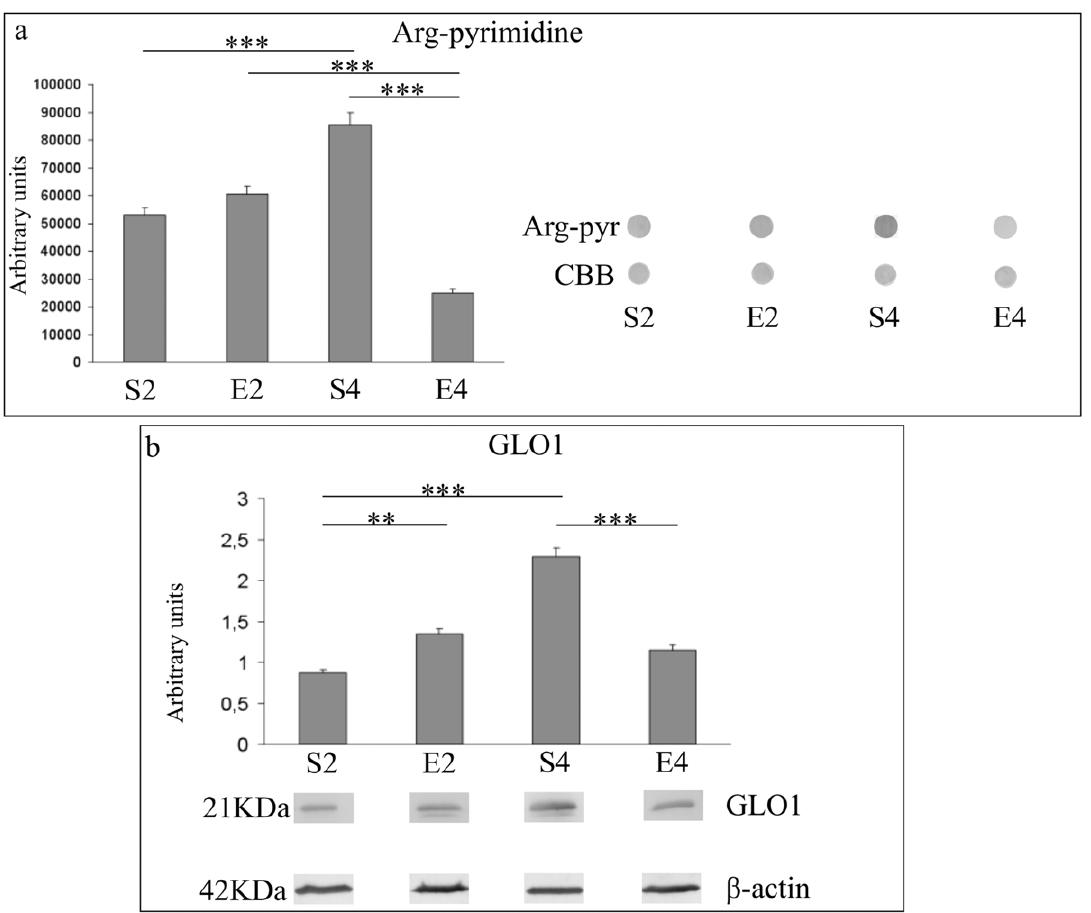
Figure 6. MG-related protein damage and expression of MG-targeting detoxification system in hippocampi of mice undergoing 2- or 4-mo moderate treadmill running. Immunoreactivity levels against arg-pyrimidine and protein expression of glyoxalase 1 (GLO1) in hippocampi of mature CD-1 female mice undergoing a two- or four-month moderate and regular treadmill-based exercise program (E2 or E4, respectively); age-matched sedentary animals (S2, S4) were used as controls (n=12 per group). As shown in panel a, an age-dependent increase in the levels of MG-damaged protein was detected (S4 vs S2), and an increasing trend in MG-related protein damage was observed after 2 months of running (E2 vs S2). The immunoreactivity against arg-pyrimidine decreased after 4 months of regular exercise (E4 vs S4). Dot-blots signals were normalized against the Comassie Brilliant Blue-based total protein staining. In the panel a, right section, representative dot immunoblots of three independent experiments were reported. As reported in panel b, an age-dependent increase in the GLO1 protein expression levels was detected (S4 vs S2). 2-mo exercise increased GLO1 protein levels (E2 vs S2), while the expression levels of GLO1 decreased after four months of regular running (E4 vs S4). Immunosignals were normalized against the housekeeping b -actin. Representative western immunoblots of three independent experiments were reported in panel b. Values were given as means 6 std. dev. The level of statistical significance was computed by using two-way ANOVA and post-hoc Newman-Keuls test: *** P , 0.001; ** P , 0.01. Experiments were performed in